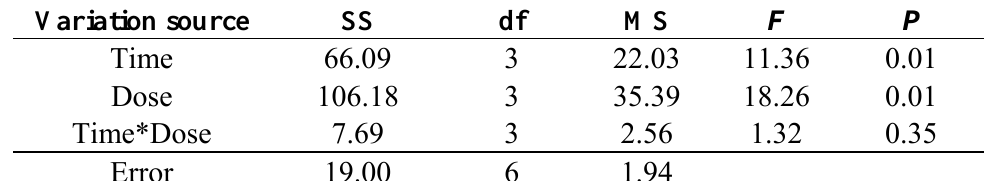
Table 7. ANOVA of positive cells of